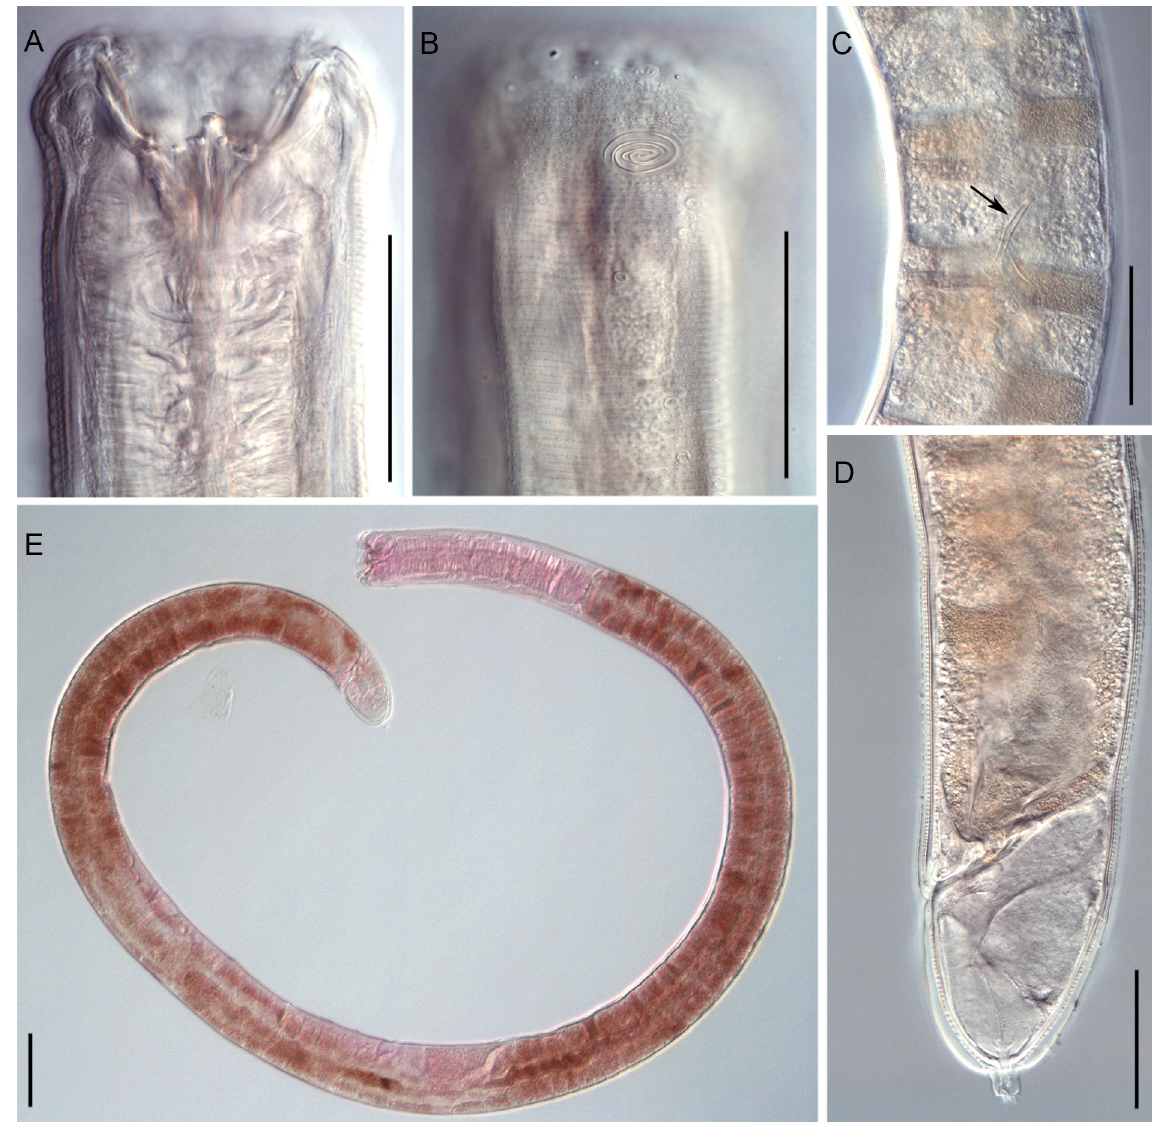
Fig. 7. Synonchium caudatubatum sp. nov., paratypes, ♀♀. A–B . Head, showing the same structures as male holotype. C . Spicules (arrow) of prey nematodes left in the intestine. D . Tail, showing the caudal glands with spinneret and the bluntly rounded tail with a protuberant caudal duct. E . Overview, showing the slightly slender body shape and two opposed testes. Scale bars: A–D = 50 µm, E = 100